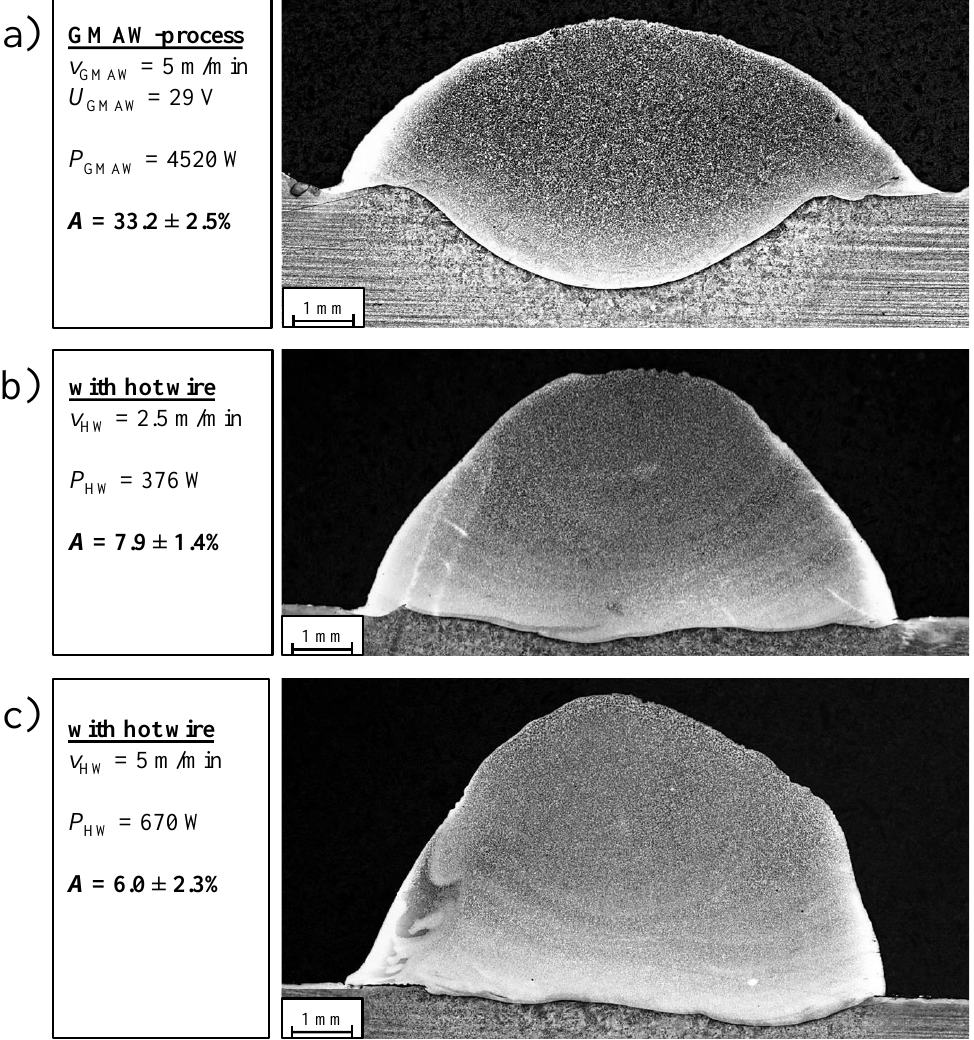
Figure 4. Influence of an additional hot wire on the dilution rate, A , and macroscopic melt bead features during gas metal arc welding (GMAW). ( a ) Cross section of conventional GMAW ( v GMAW = 5 m/min) with a dilution rate A of 7.9% ( b ) by applying an additional hot wire ( v HW = 2,5 m/min), the dilution rate A decreased to 7.9%, ( c ) by applying an additional hot wire ( v HW = 5 m/min), the dilution rate A decreased to 6.0%.